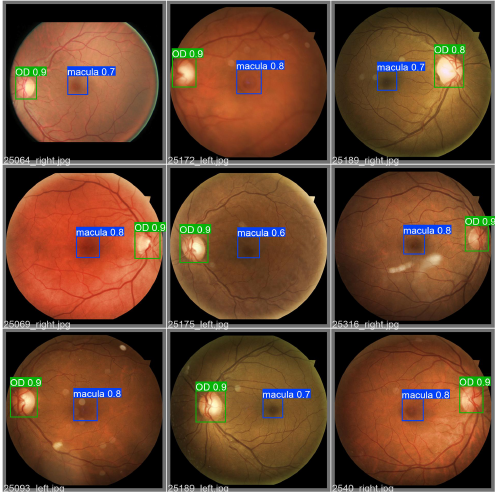
Figure 12. Set of 9 validation RFIs object detection results obtained by the YOLOv5 model. The macula and OD are detected with their respective confidence value. Table 9. Object detector training